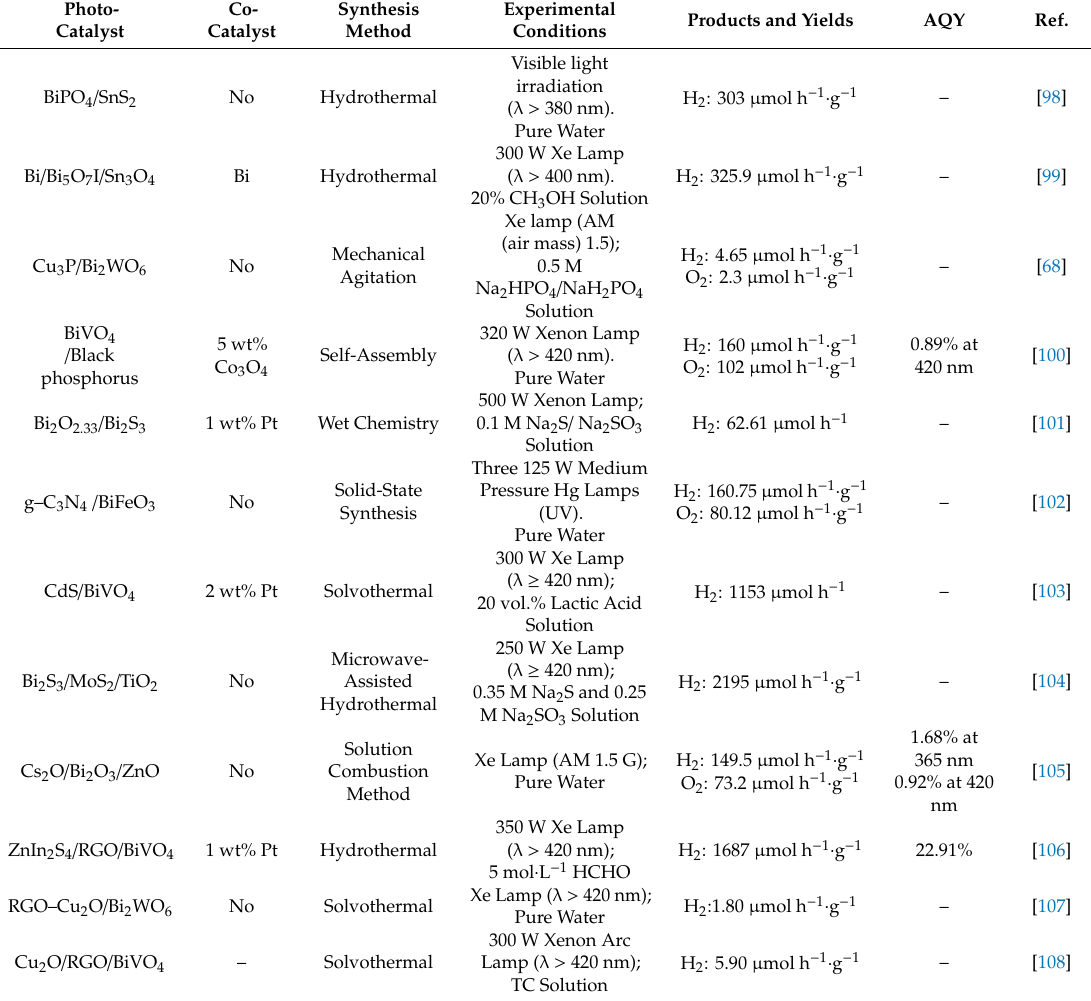
Table 3. Research progress of Bi-based Z-Scheme photocatalyst applied in solar-water splitting. Photo- Co- Synthesis Experimental Products and Yields AQY Catalyst Catalyst Method Conditions